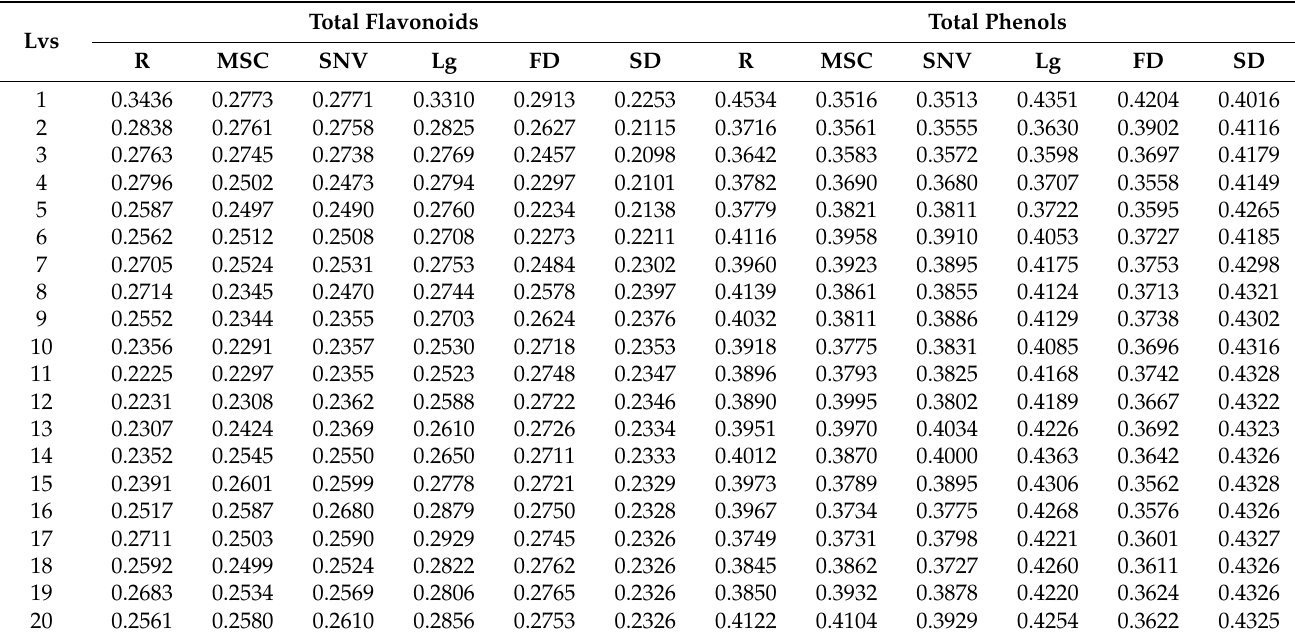
Table 3. Selection of latent variables of the model based on different transformation spectra.